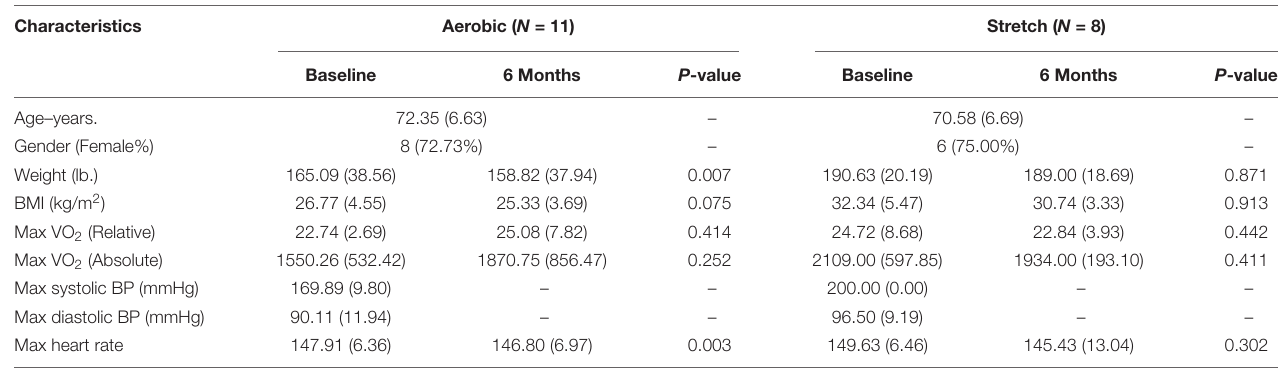
TABLE 1 | Baseline characteristics of participants (completers with methylation data).